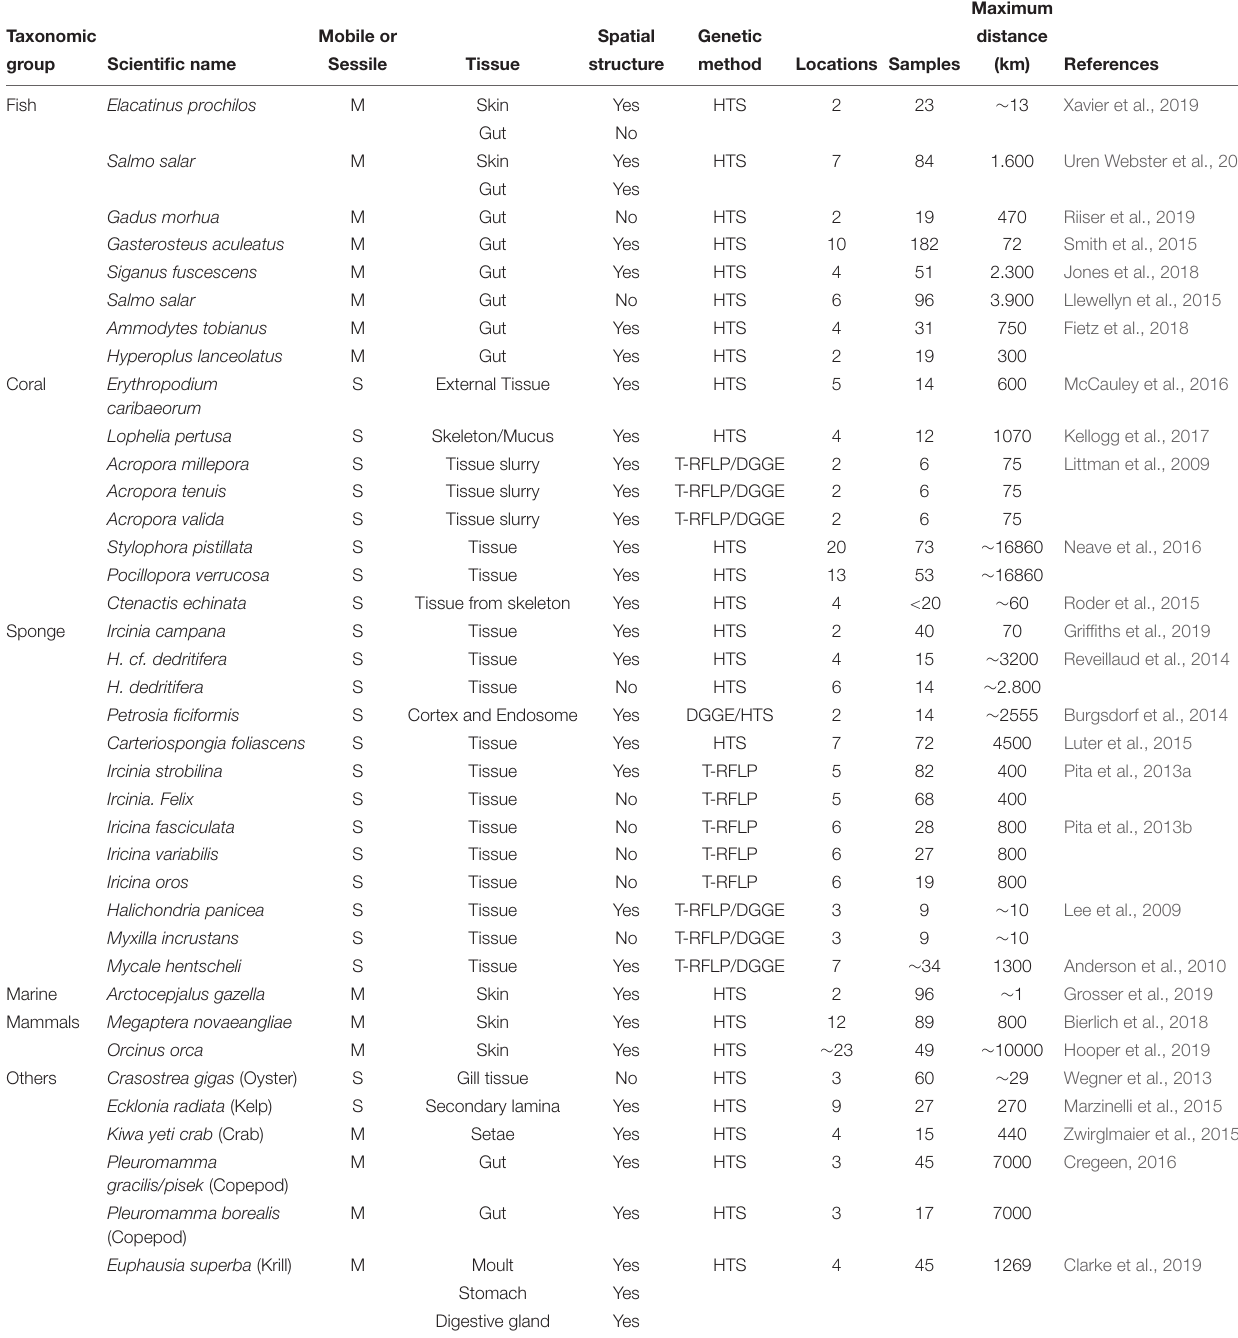
TABLE 1 | Data on presence or absence of spatial structure in marine host-associated microbiomes for 38 species extracted from 28 research papers.